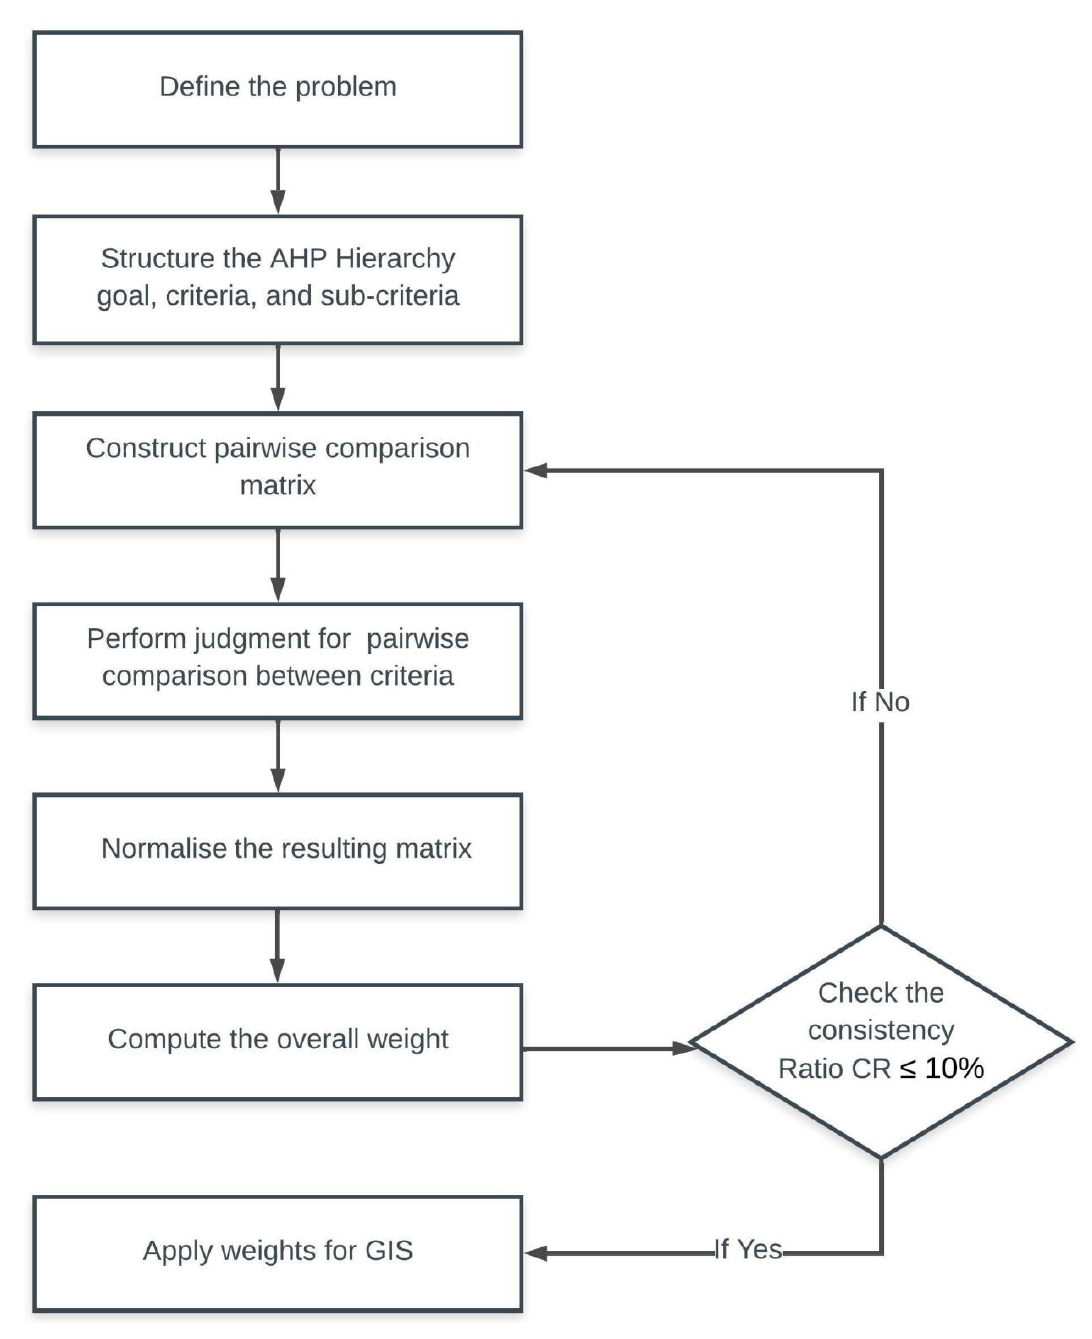
Figure 4. The steps of the AHP method. Table 2. Pairwise comparisons on a relative scale.